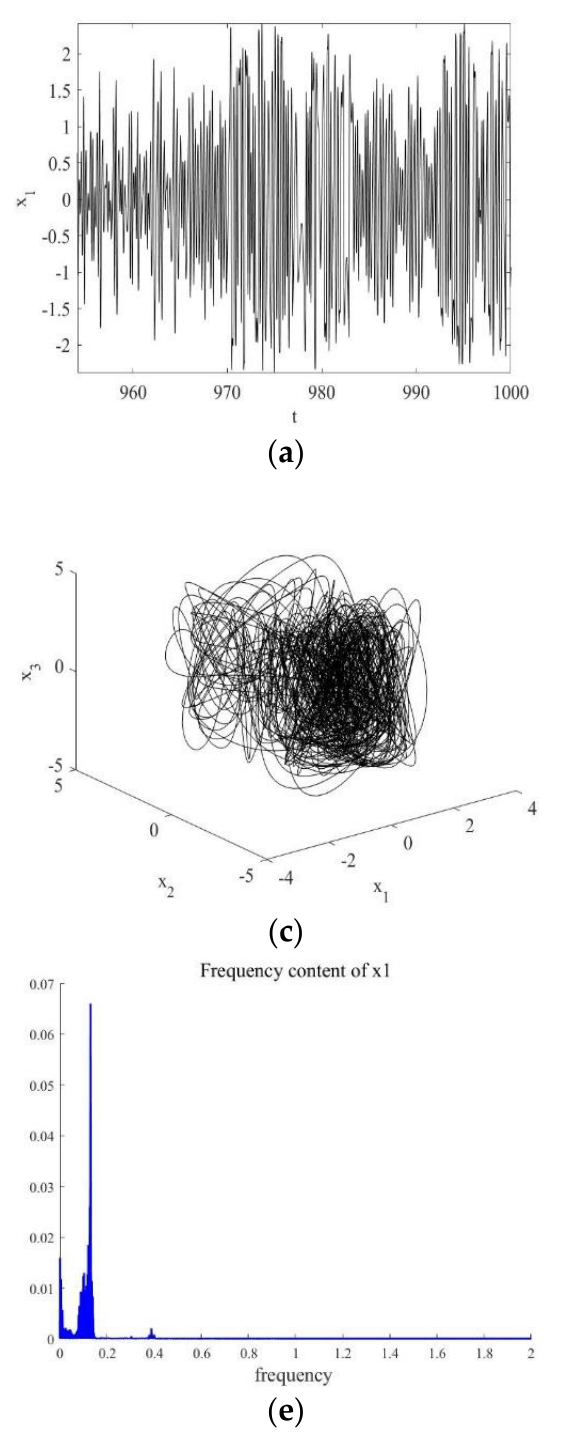
30 F = Figure 13. The trajectory under the condition F 3 = 30. ( a ) The waveform on the plane ( t , x 1 ); ( b ) The Figure 13. The trajectory under the condition . ( a ) The waveform on the plane ( 3 phase portrait on the plane ( x 1 , x 2 ). ( c ) The phase portrait in the three-dimensional space ( x 1 , x 2 , x 3 ). x x ( b ) The phase portrait on the plane ( , ). ( c ) The phase portrait in the three-dimensional space ( d ) The Maximum Lyapunov exponent plot of x 1 . ( e ) The power spectrum of x 1 . ( f ) The Poincare 1 2 map on the plane ( x 1 , x 2 x x x x ( , , ). ( d ) The Maximum Lyapunov exponent plot of . ( e ) The power spectrum of 1 2 3 1 x x ( f ) The Poincare map on the plane ( , ). 1 2